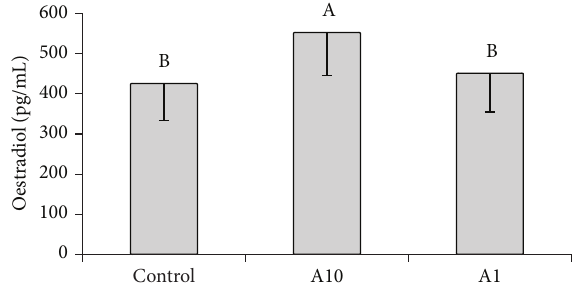
Figure 4: The effect of adiponectin (10 𝜇 g/mL-A10 and 1 𝜇 g/mL-A1) on basal oestradiol secretion by cultured granulosa cells collected on days 17–19 of the oestrous cycle. Bars with different superscripts are significantly different ( 𝑃 < 0.05 ). Results are means ± S.E.M. of five replicates.